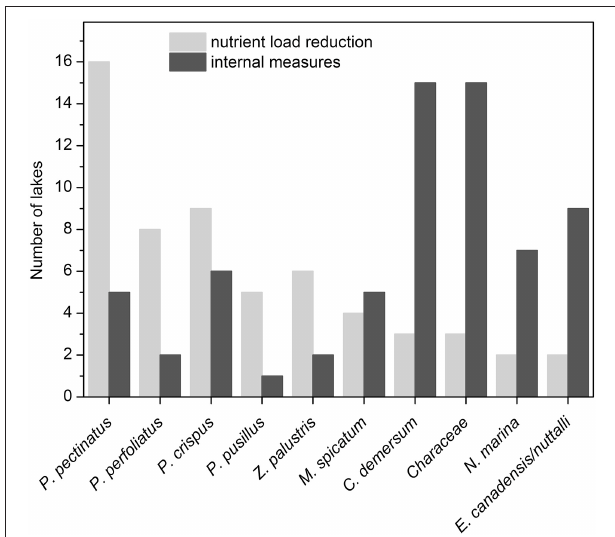
FIGURE 6 | The 10 most common macrophyte taxa in north temperate shallow lakes during re-colonization after reduction of external nutrient loading (light gray) or implementation of internal measures (dark gray; for more details see Tables 1 , 2